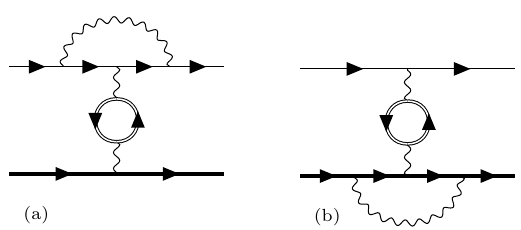
Figure 4. Factorisable NNLO contribution with vacuum polarisation insertion on the tree-level photon propagator of one-loop photonic correction diagrams.